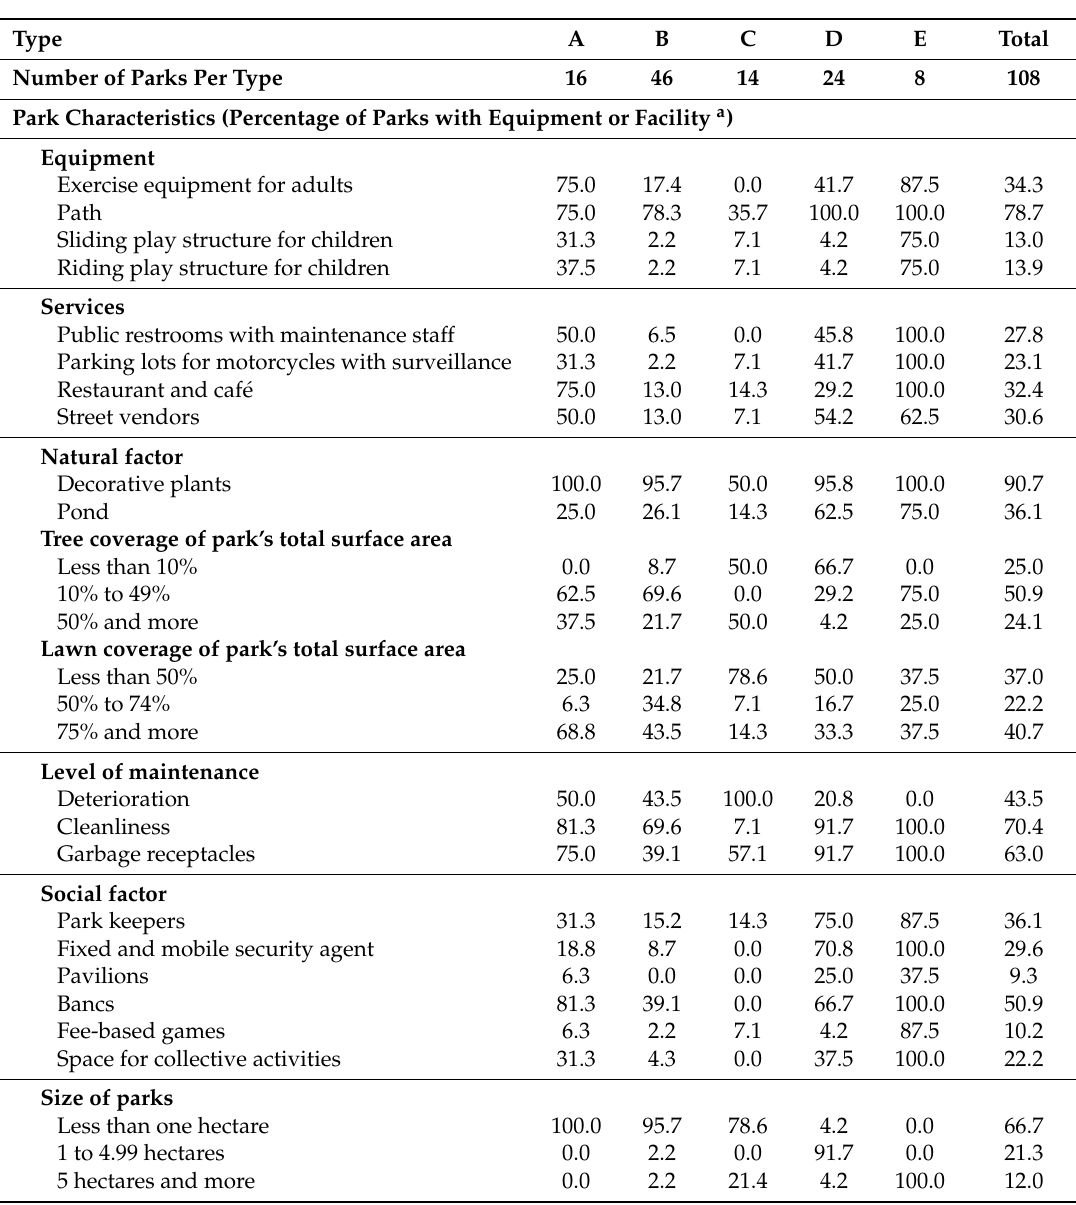
Table 2. Typology of urban parks in